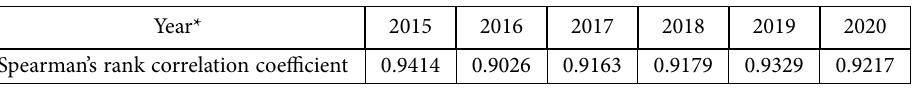
Table 4. Correlation among original and new DESI